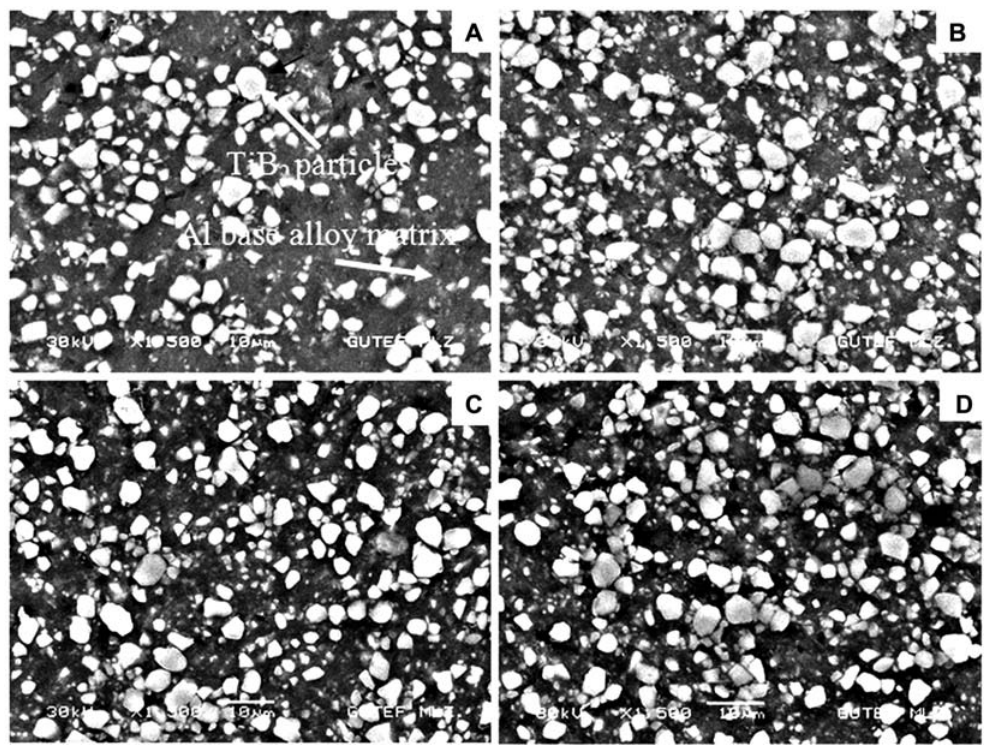
Figure 2 SEM images of A356 matrix composites reinforced with (A) 5 % TiB